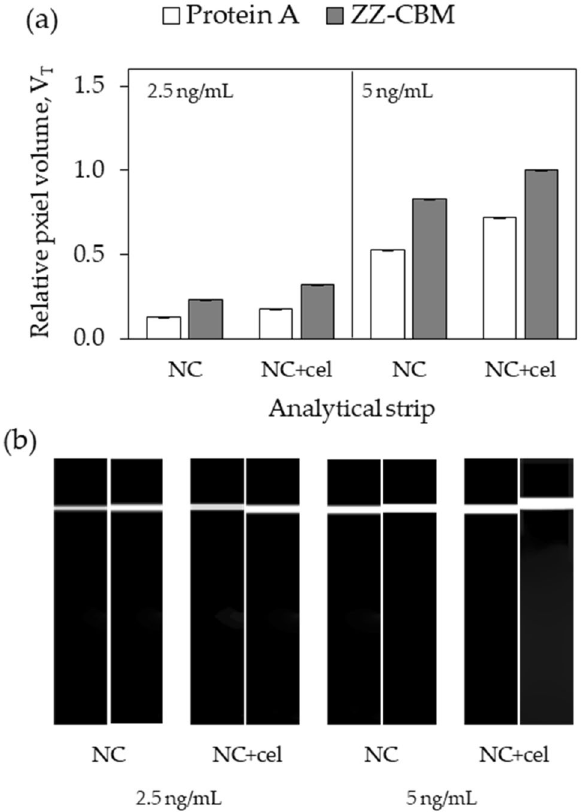
Figure 4. Comparative capture of Alexa-labeled antibodies by protein A and ZZ-CBM3 fusions dispensed on test lines of LFA. Experiments were performed using analytical strips of NC and of NC with a coat of cellulose (NC + cel) on the test line. Samples containing either 2.5 or 5 ng/mL Alexa-antibodies were tested. ( a ) The pixel volume of test lines, V T , was normalized relatively to the highest pixel volume obtained in the experiments. ( b ) Representative fluorescence images of the test line region of strips (protein A left, ZZ-CBM3 right) obtained by the ImageQuant camera are shown. Experiments were performed in triplicate.